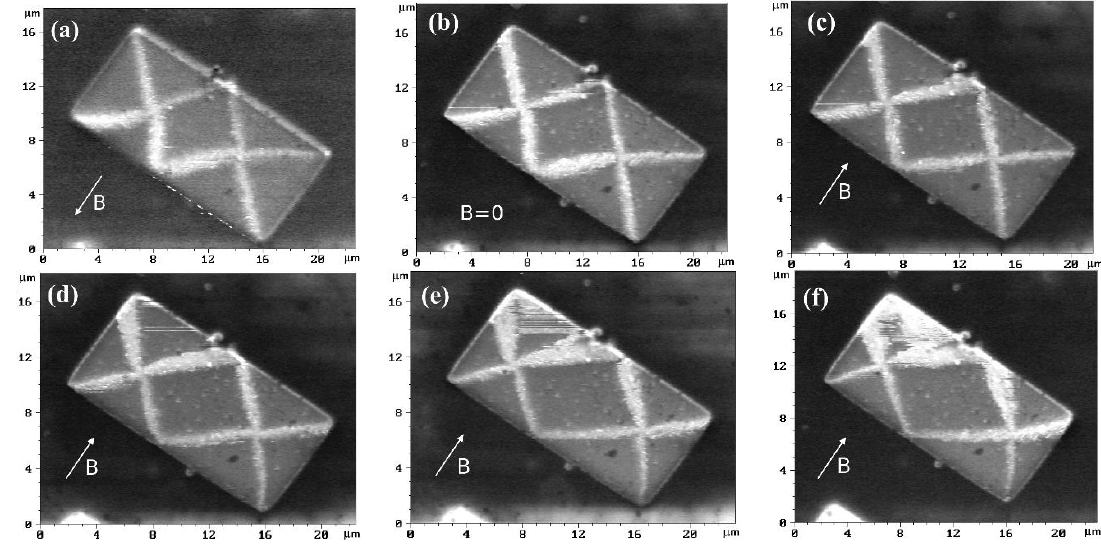
Figure 4. MFM images of rectangular microstructures in an external magnetic field: ( a ) −15, ( b ) 0, ( c ) +15, ( d ) +30, ( e ) +45 and ( f ) +60 G. Effective exchange field was formed along the long side of the rectangles. The arrows indicate an external magnetic field. The vertical scale is the phase shift and ranged from 0° (black) to 2° (white).